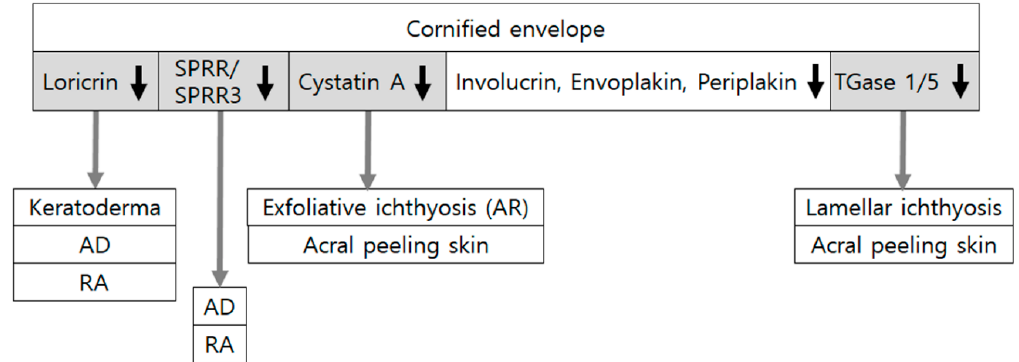
Figure 3. Downregulation of cornified envelope components in skin diseases and experimental conditions related to epidermal barrier dysfunction. Cornified envelopes are composed of various molecules, such as involucrin, loricrin, small proline-rich proteins (SPRRs), envoplakin, periplakin, and cysteine protease inhibitor A (cystatin A), crossed-linked by transglutaminases (TGases). Loss-of-function mutations in SPRR / SPRR3, LOR (encoding loricrin), TGM1 / TGM5 (encoding transglutaminase1 / 5), and CSTA (encoding cystatin A) have been associated with atopic dermatitis (AD) or ichthyoses. Expression levels of loricrin and SPRRs have been reduced in experimental conditions of the disrupted epidermal barrier by retinoic acid (RA) application. Although triple knocking-out of envoplakin, periplakin, and involucrin induces abnormal cornified envelopes, mutations or deficiencies of involucrin alone do not cause atopic dermatitis.